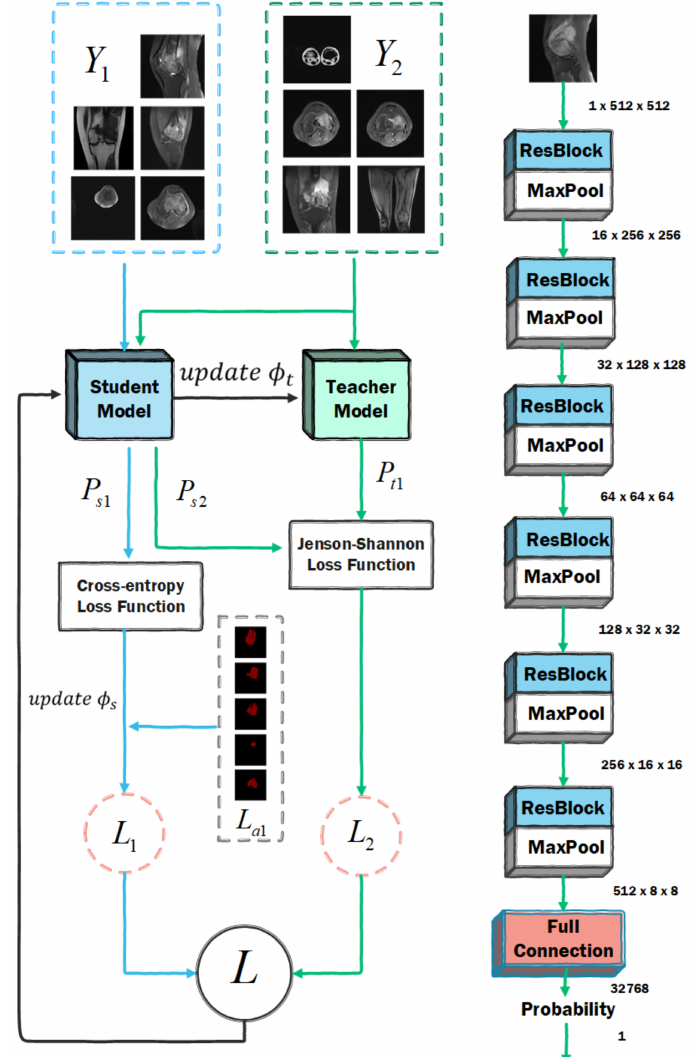
Figure 2. Dataset optimization network architecture